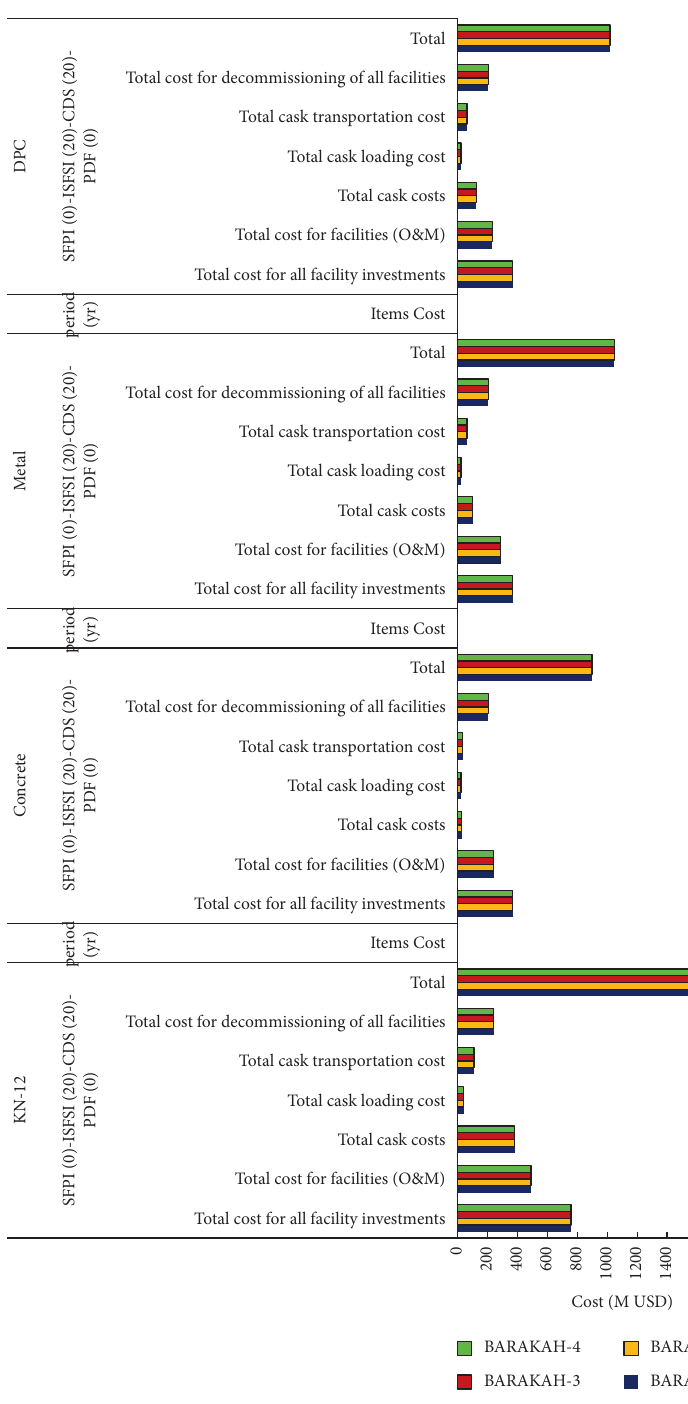
Figure 20: Total cost per cost category for different types of cask storage, for Sc-8 of Barakah